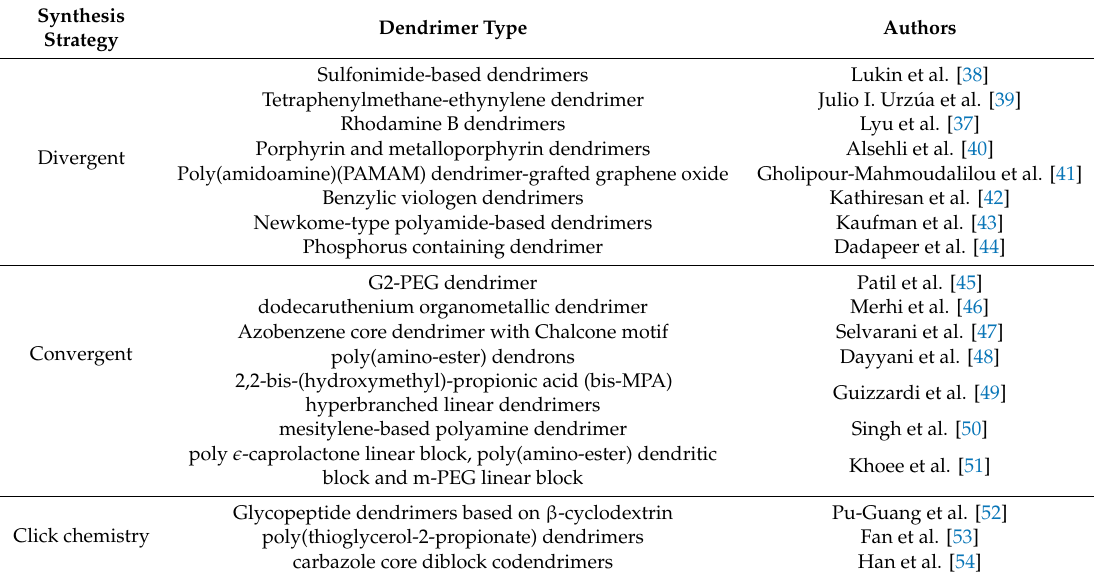
Table 1. Summary of some synthetic strategies and dendrimers